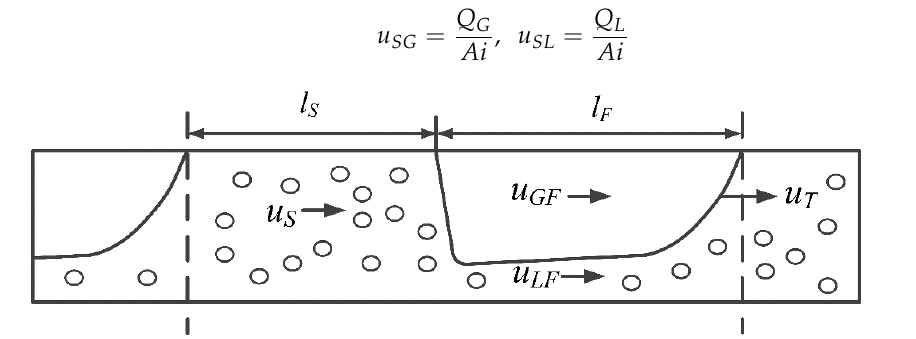
Figure 2. Schematic of a stable slug unit.